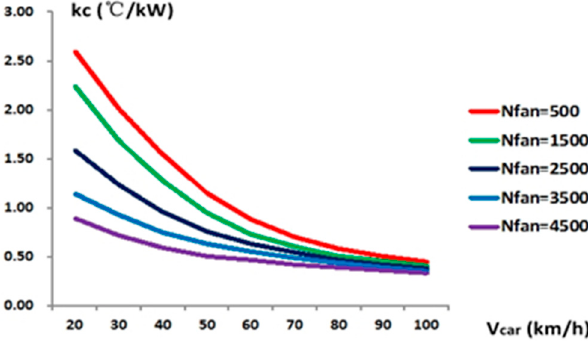
Figure 15. Coupling factor curves of the condenser.